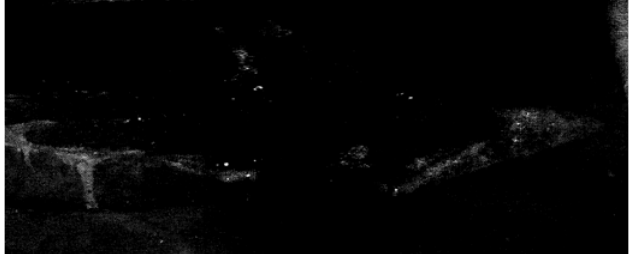
Fig 1: Patient with necrotising fasciitis of left lower limb following intra-articular left knee steroid injection. Presence of necrotic fas- cia present in surgical incisions and subcutaneous fat necrosis at the knee level is